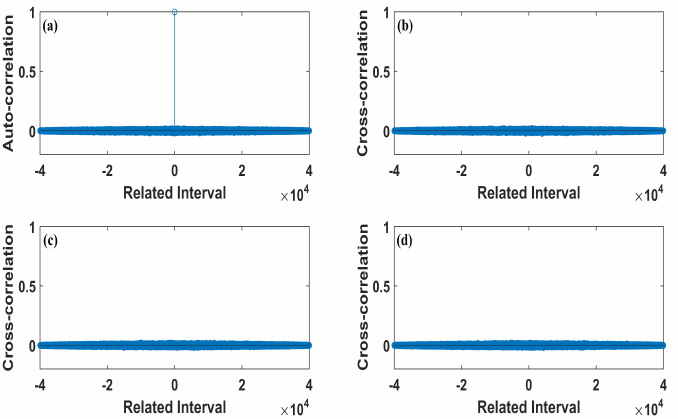
Figure 11. ( a ) Auto-correlation and ( b ) cross-correlation for x 0 = 0.1 and ˆ x 0 = 0.1 + 10 − 16 , with b = 1.99, a = 1, ( c ) cross-correlation for b = 1.99 and ˆ b = 1.99 − 10 − 15 , with x 0 = 0.1, a = 1, ( d ) cross-correlation for a = 1 and ˆ a = 1 + 10 − 15 , with x 0 = 0.1, b =